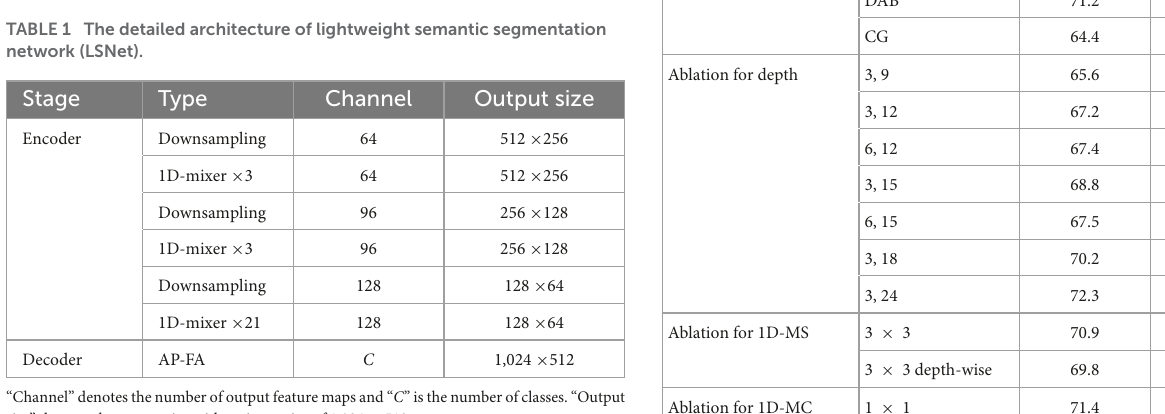
and deconvolution of the depth-wise convolution kernel sizes we use are (3 × 1, 5 × 1, and 7 × 1). There are two main reasons for using decomposed convolution here. One is that banded convolution meets the needs of lightweight networks, and the second is that most detected targets are banded. Therefore, using banded convolution is helpful for feature decoding. In the spatial attention branch, two kinds of pooling are used to obtain global information from multiple aspects and are encoded by 1 × 7 and 7 × 1 convolutions. 1 × 7 and 7 × 1 large convolutions can extract spatial features very well. AP related details are shown in Figure 2C .